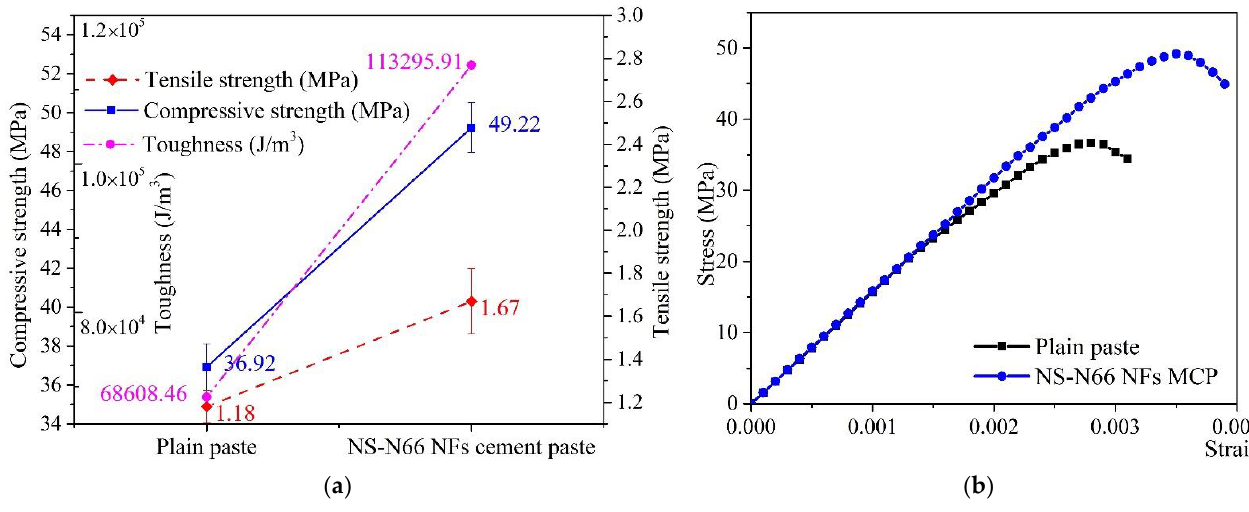
Figure 2. ( a ) The mechanical behaviors of the cement pastes at 28 days; ( b ) The constitutive curves, where “ MCP ” implies “ modified cement paste ” . Table 2. Comparison of the mechanical strength results with [16] (the increase in %).